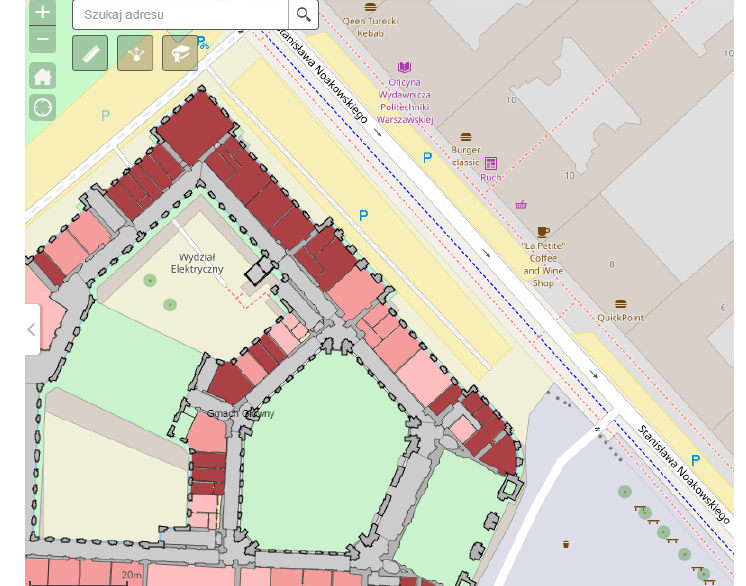
Fig. 1. The results of the attempt at “seamless” presentation of the interior of a building and its surroundings (prototype of the spatial information system of the Warsaw University of Technology, own data and